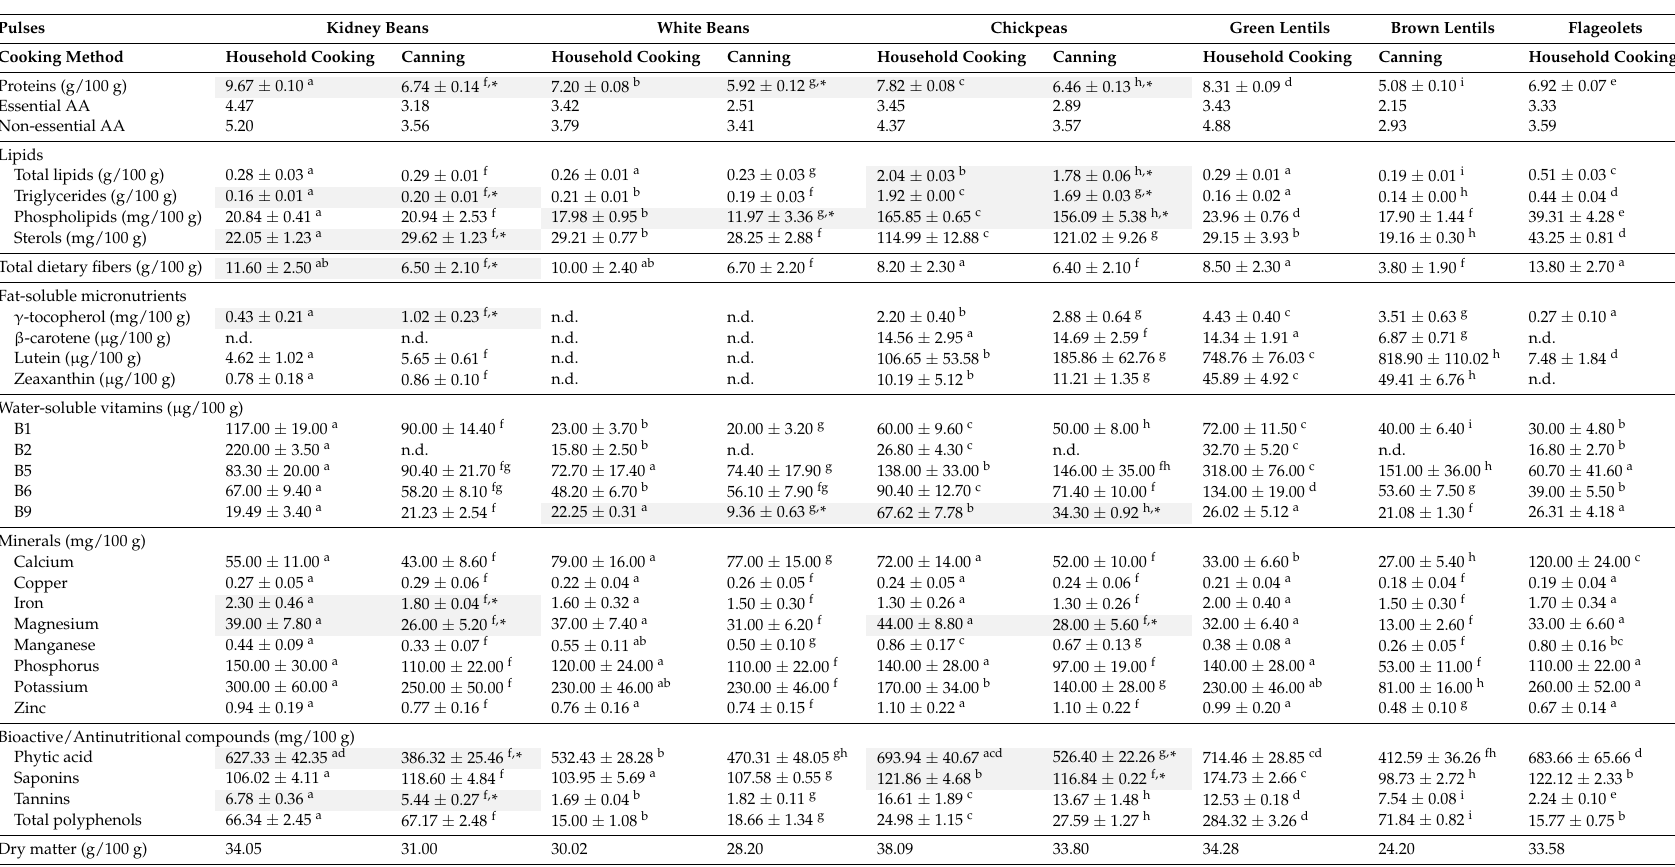
Table 1. Nutritional and bioactive compound compositions of prepared kidney beans, white beans, chickpeas, green and brown lentils, and flageolets. Pulses Kidney Beans White Beans Chickpeas Green Lentils Brown Lentils Flageolets Cooking Method Household Cooking Canning Household Cooking Canning Household Cooking Canning Household Cooking Canning Household Cooking Proteins (g/100 g)